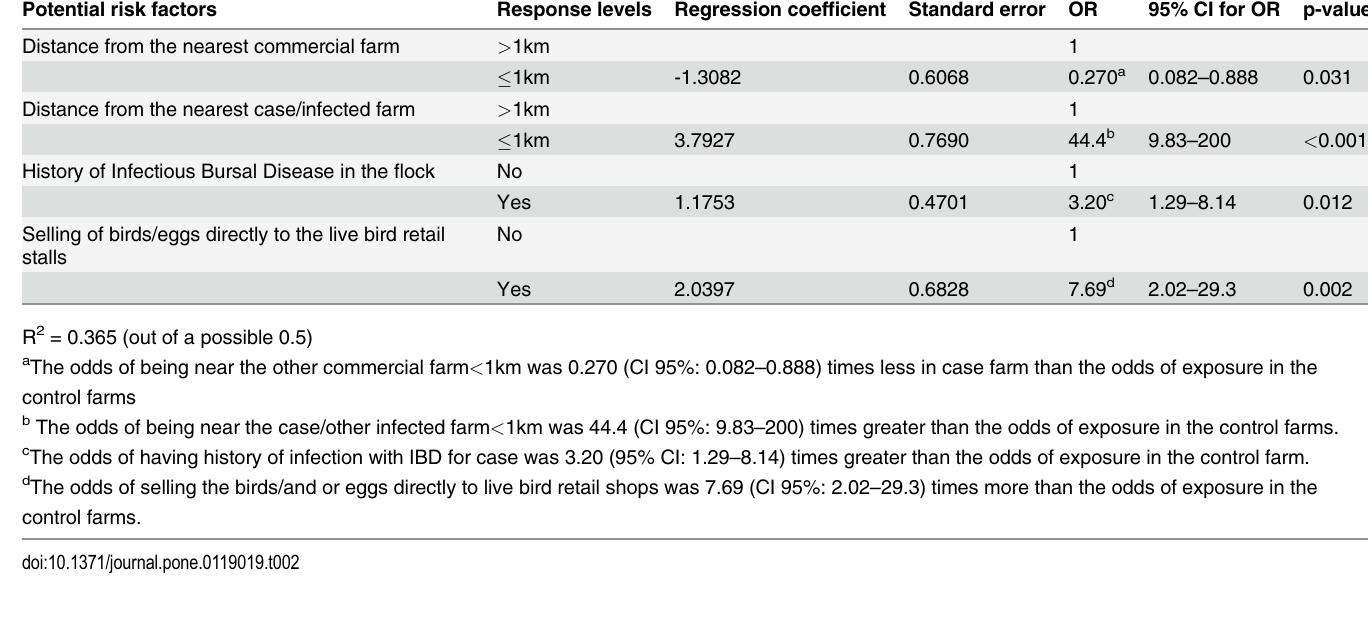
Table 2. Model 1 — Risk factors associated with Avian In fl uenza type H9N2 infection on commercial poultry farms in Pakistan based on a backward manual stepwise selection process on all variables available in Table 1. Potential risk